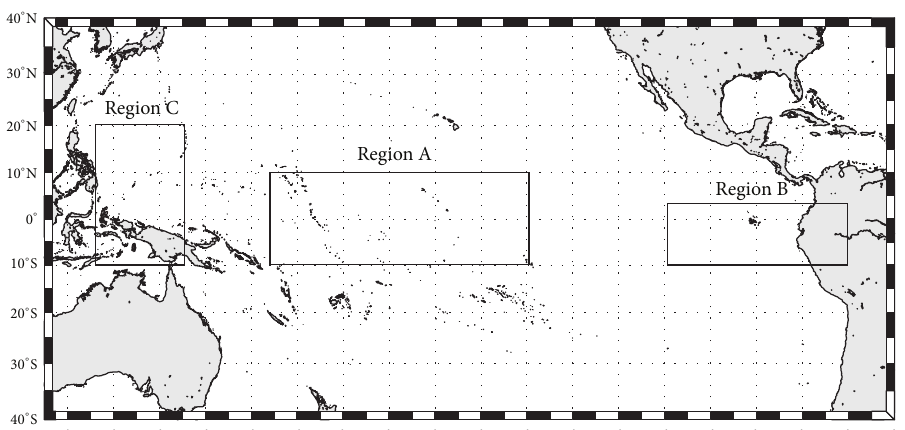
Figure 2: The regions for the definition of